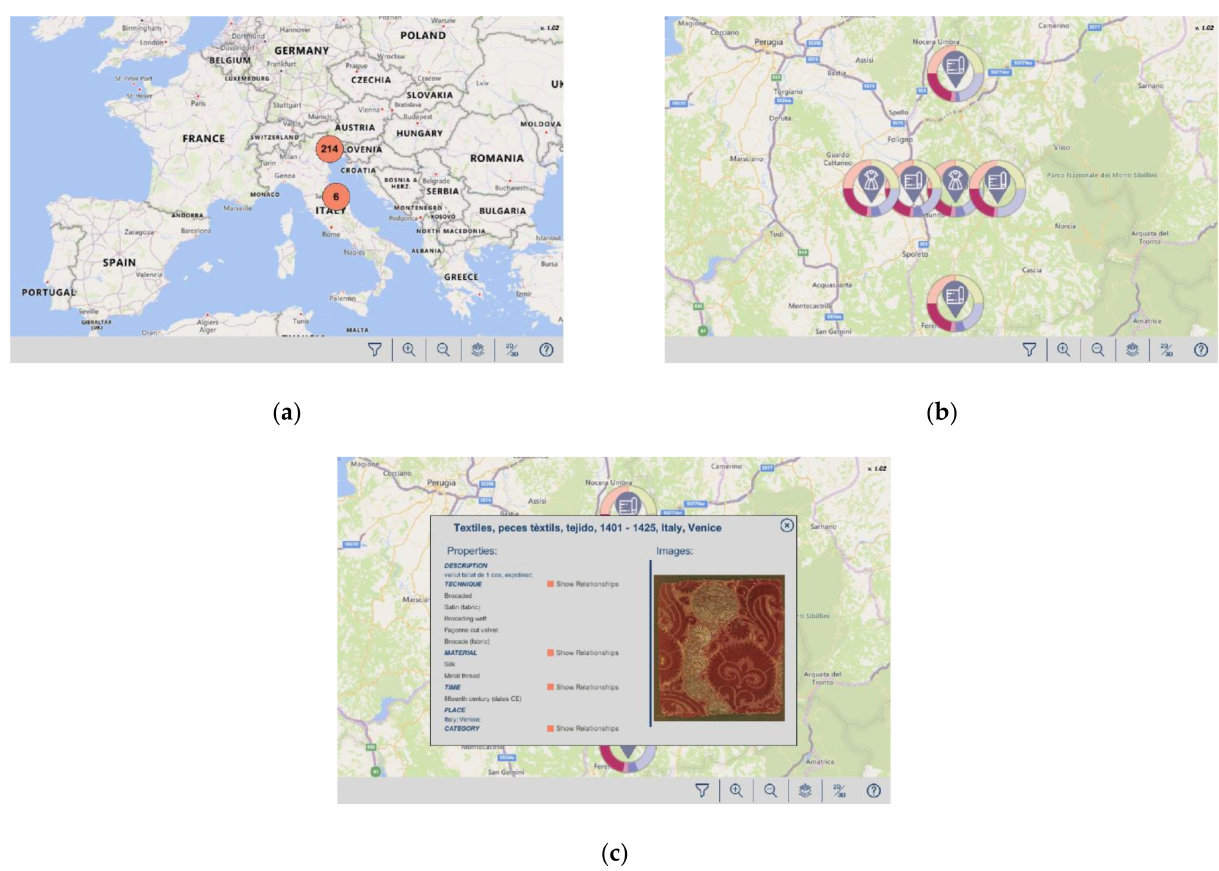
Figure 11. Example of objects that have multiple locations, where: ( a ) results of a query; ( b ) depiction of objects with multiple locations; and ( c ) details of one of the